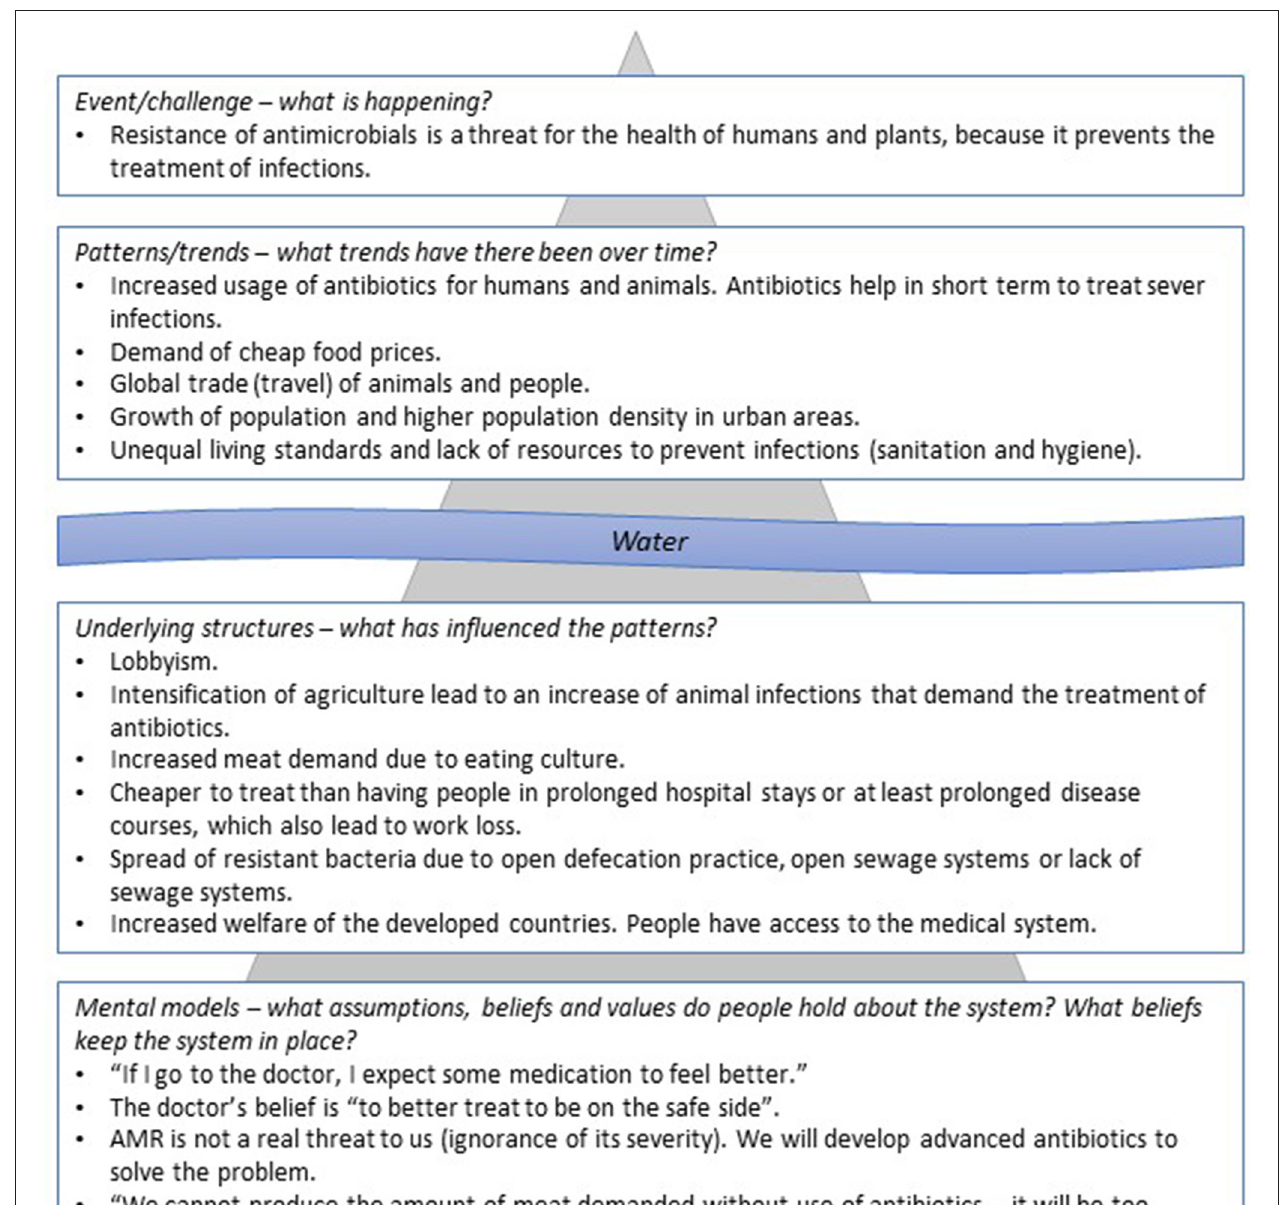
Frontiers in Public Health |